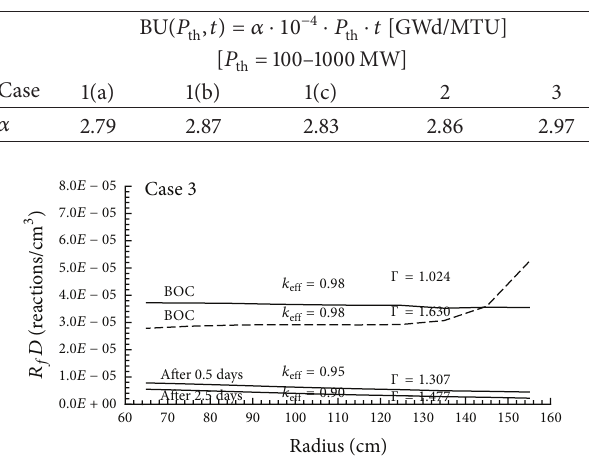
Figure 9: Variations of fission densities in the fuel core at the beginning and at the end of the cycle versus the core radius (solid lines indicate the flattened power